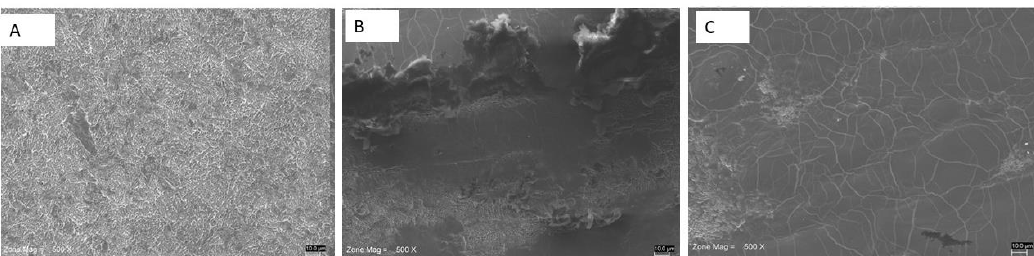
Figure 6. Scanning Electron Microscopy (SEM) analysis. ( A ) The disk surface of controls shows a nanoporous network structure of typical microroughness imparted by SLA (no treatment). ( B ) Group 2 showed delamination and deformation of the surface present in the laser irradiated areas. ( C ) Group 3 showed signs of coagulation, melting, and microfractures.